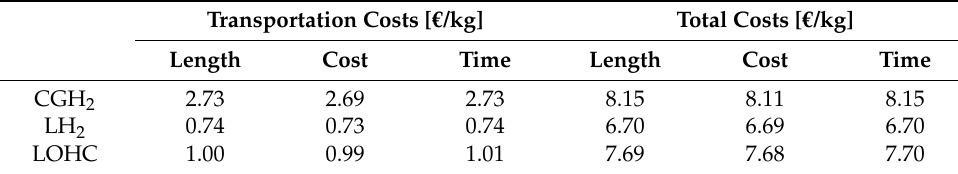
Table 5. Optimized transportation and total costs for each